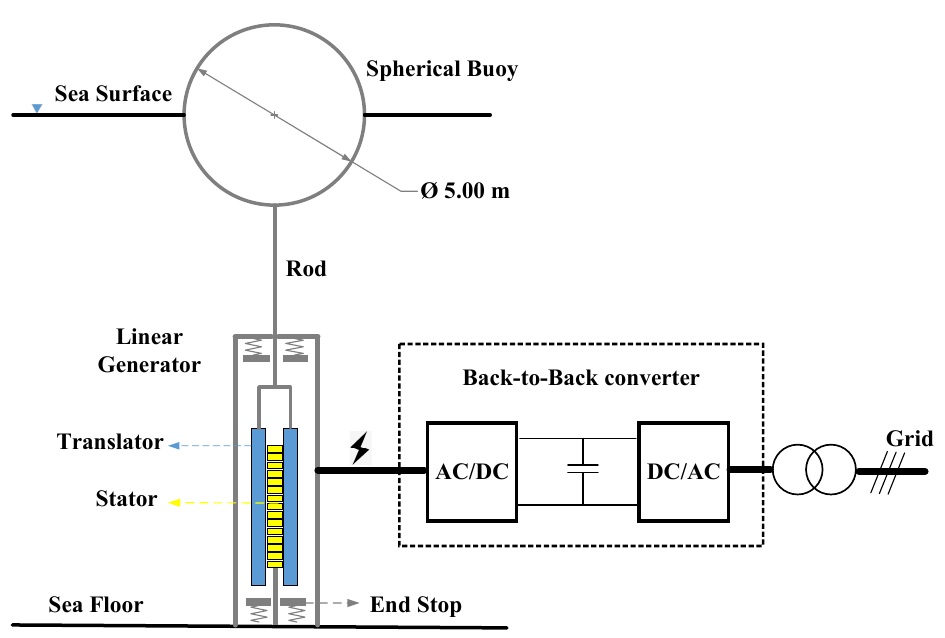
Figure 1. Schematic of the heaving point absorber WEC, and the connection scheme of the PM linear generator with the back-to-back converter and the grid.